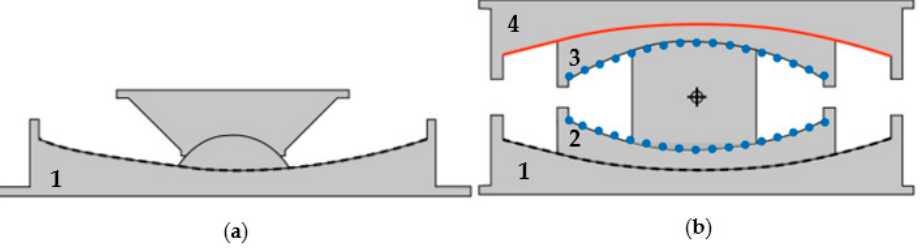
Figure 1. Section view of: ( a ) SFPB and ( b ) TFPB (Reprinted from Computers and Structures, Volume 243, Alexandros Tsipianitis and Yiannis Tsompanakis, Optimizing the seismic response of base- isolated liquid storage tanks using swarm intelligence algorithms, Pages No. 106407,Copyright (2022), with permission from